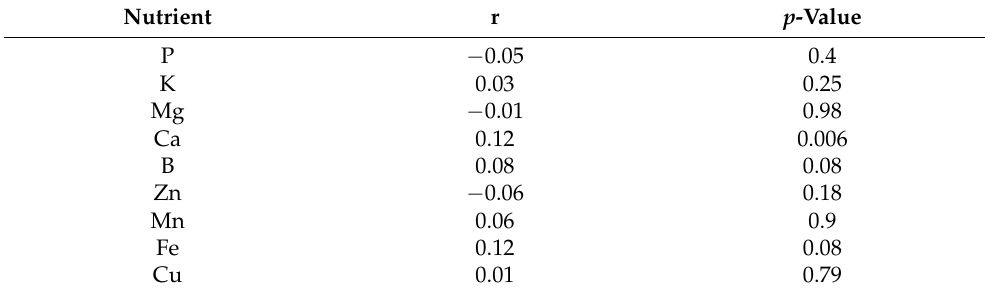
Table 1. Corresponding p -values and r values (Pearson’s coefficient) of correlations examined between soil nutrient concentrations and planting density treatments from all time points of sampling, which